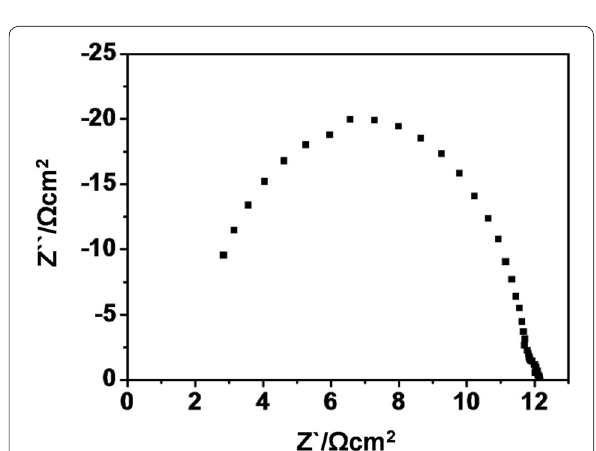
Fig. 5 Nyquist plot of the impedance spectra of the YSZ-NT array- based MEA measured under H 2 ambient at 400